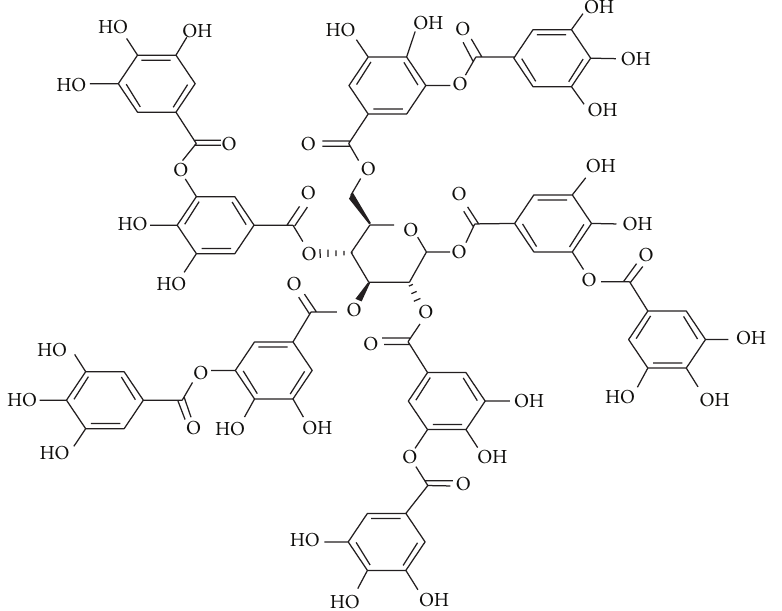
Figure 1: Molecular structure of tannic acid (C 76 H 52 O 46 ) carrying numerous phenolic